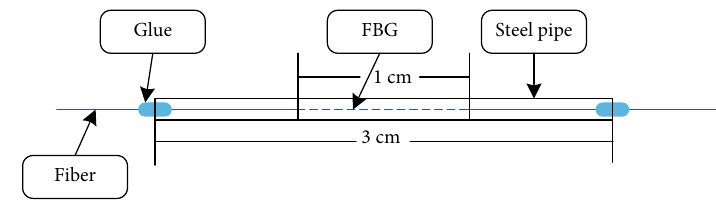
Figure 5: Structure of a single